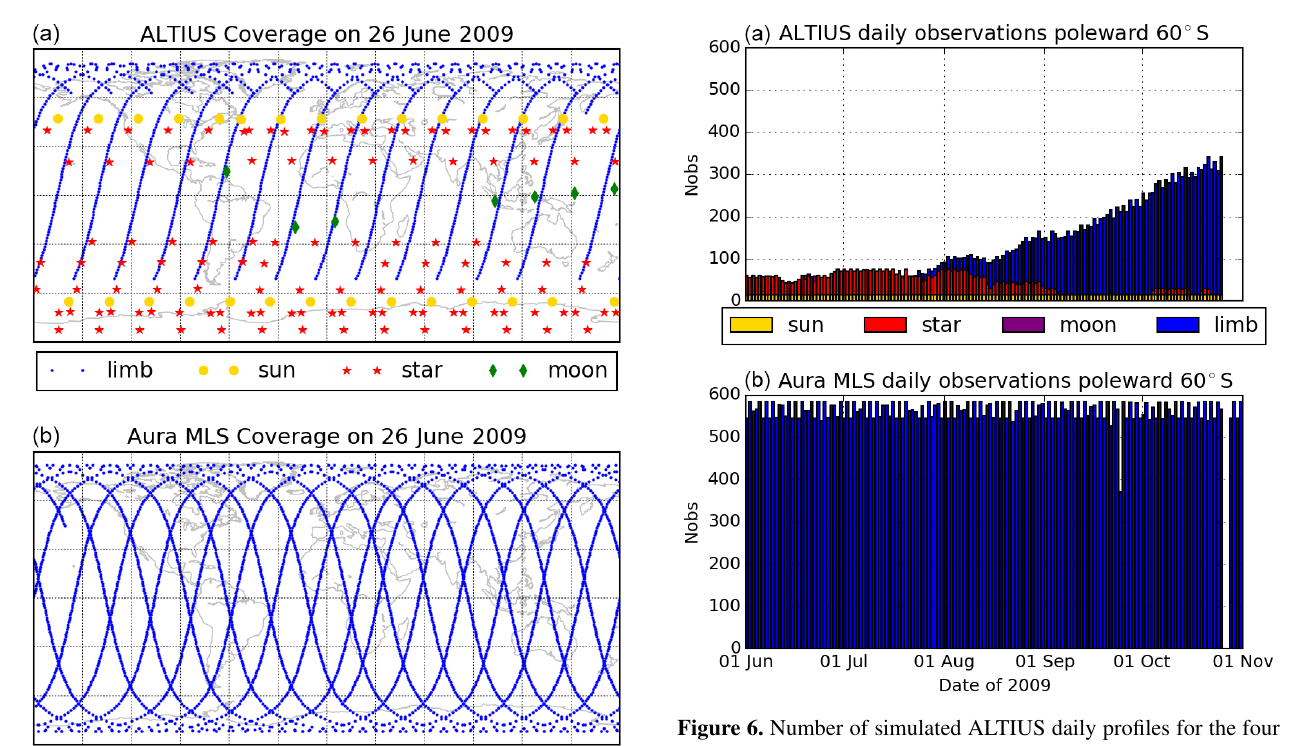
Figure 5. Simulated daily spatial coverage of the four ALTIUS modes (a) as compared with Aura MLS (b) on 26 June 2009.